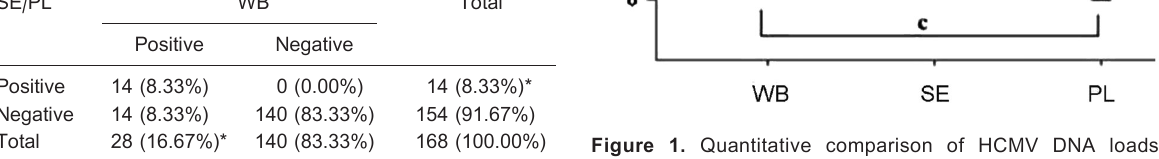
Table 1. Positive rate of HCMV DNA in whole blood (WB) and serum (SE)/plasma (PL). SE/PL